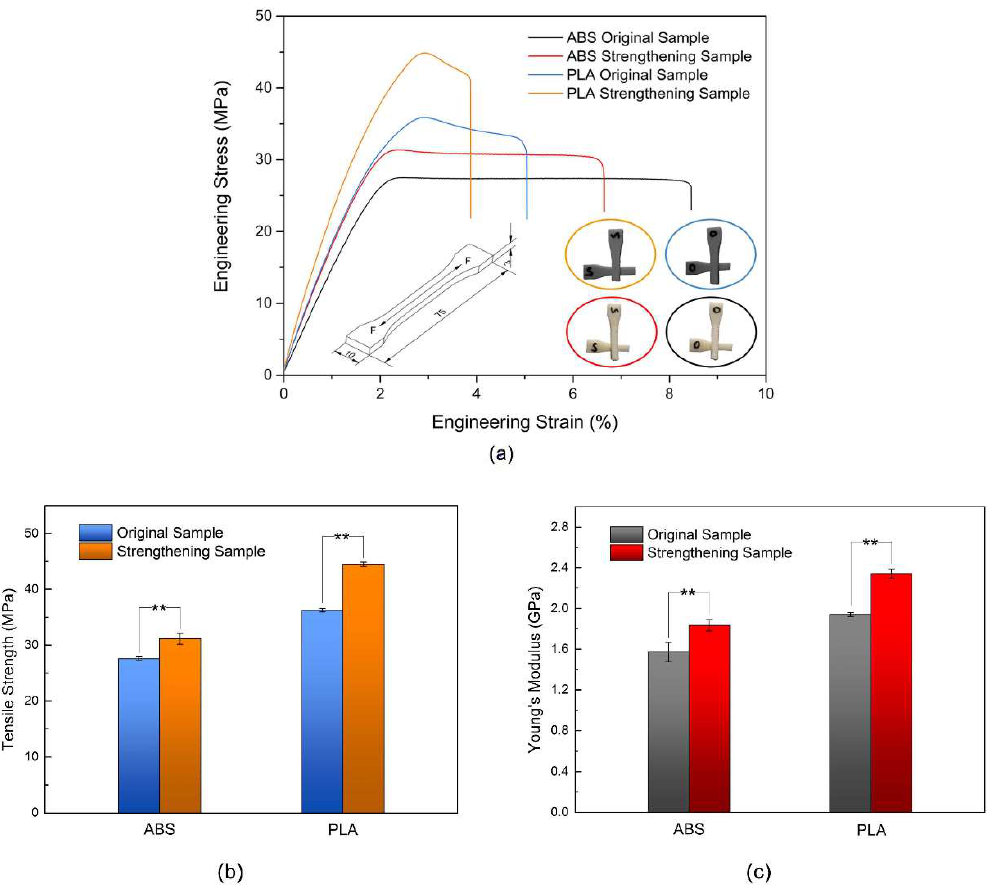
Figure 2. Tensile stress–strain curves ( a ); tensile strength ( b ); and Young’s Modulus ( c ) of original and strengthening samples. Data presented as mean ± standard deviation, ** = p < 0.01.